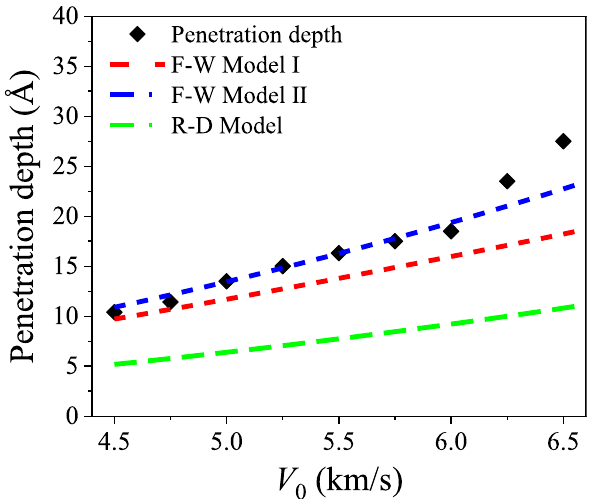
Figure 6. Comparison of penetration depth of ten-layer graphene obtained from MD simulations and continuum model predictions.